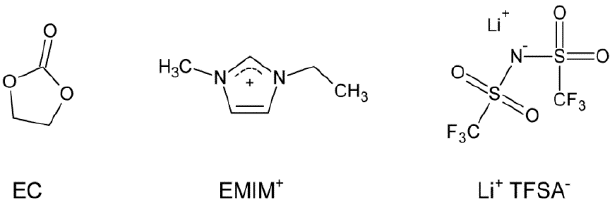
Figure 1. Chemical structures of ethylene carbonate (EC), 1-ethyl-3-methylimidazolium (EMIM) and lithium bis(trifluoromethanesulfonyl)azanide (Li-TFSA).